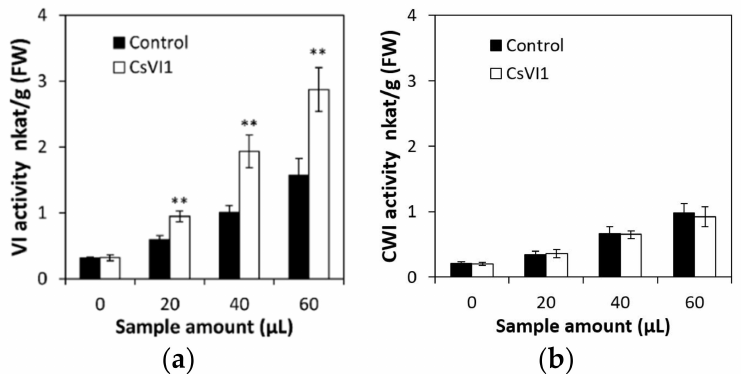
Figure 9. Cell wall and vacuolar invertase activities in Nicotiana benthamiana leaves transiently transformed with CsVI1 ( a , b ). A substrate concentration of 100 mM sucrose was used to assay cell wall and vacuolar invertase activities. The invertase activity induced by transformation with the empty vector alone was subtracted. Results are means of >3 biological replicates ( ± SE) each with three technical replicates. Asterisks indicate statistically significant differences (**, p -value <0.01).